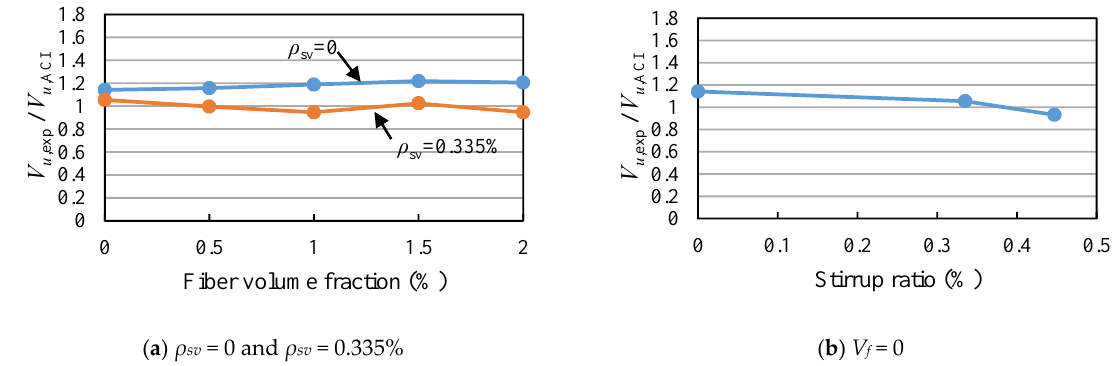
Figure 13. Comparison of test value and calculation value of ACI 544.4R. ( a ) The test beams with stirrup ratio 0 and 0.335%; ( b ) The test beams without steel fiber.